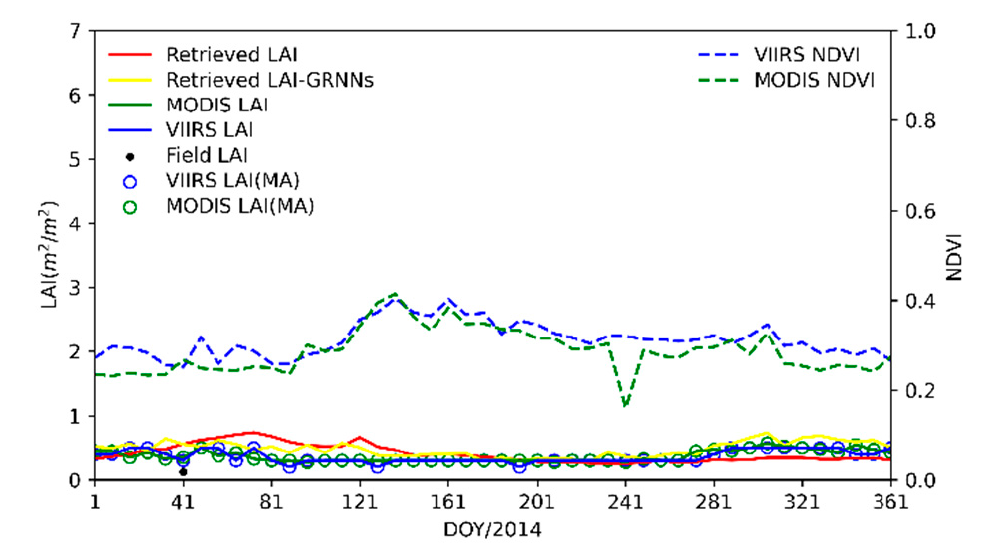
Figure 11. Temporal trajectories of the LAI-TCA and the LAI-GRNN at the center pixel of the 25de_Mayo_Shurb site for 2014.